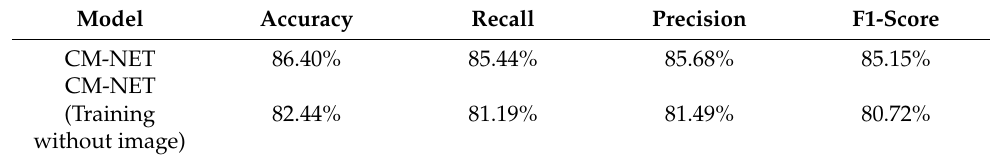
Table 1. CM-NET performance on dataset-1.